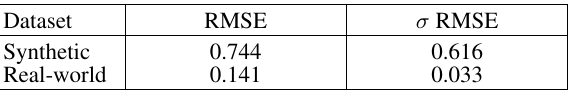
Table 4. Results for the evaluation of our 3D